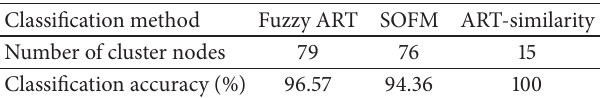
Table 5: Comparison of classification with different neural net-